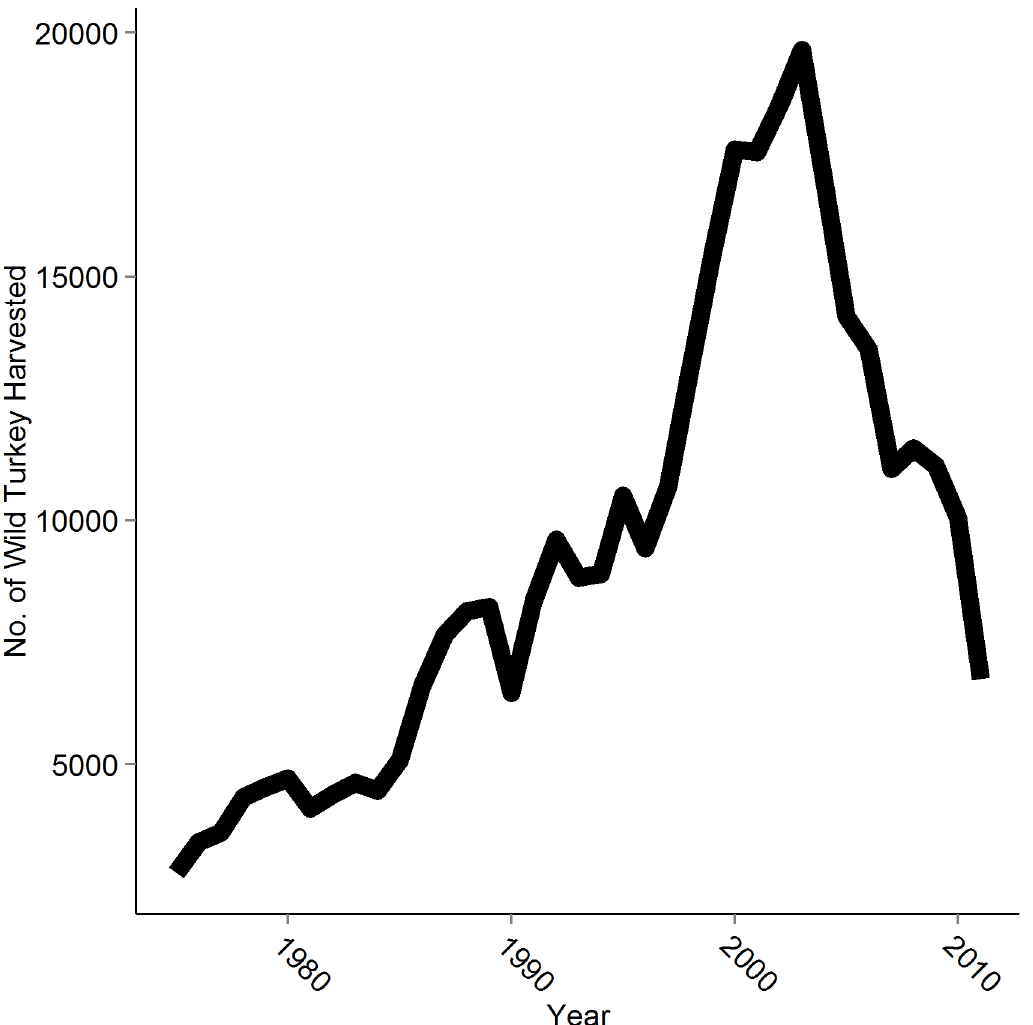
Fig 1. Estimated harvest of Eastern wild turkey ( Meleagris gallopavo silvestris ) in Arkansas from 1975 to 2010 [J. Honey, unpublished data, Arkansas Game & Fish Commission].